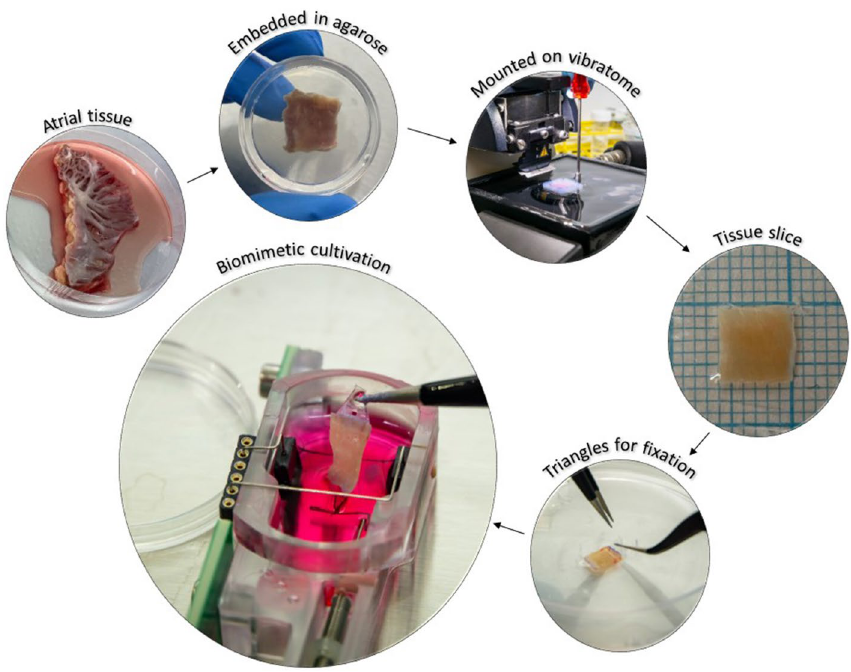
Figure 1. Schematic overview of atrial tissue slice